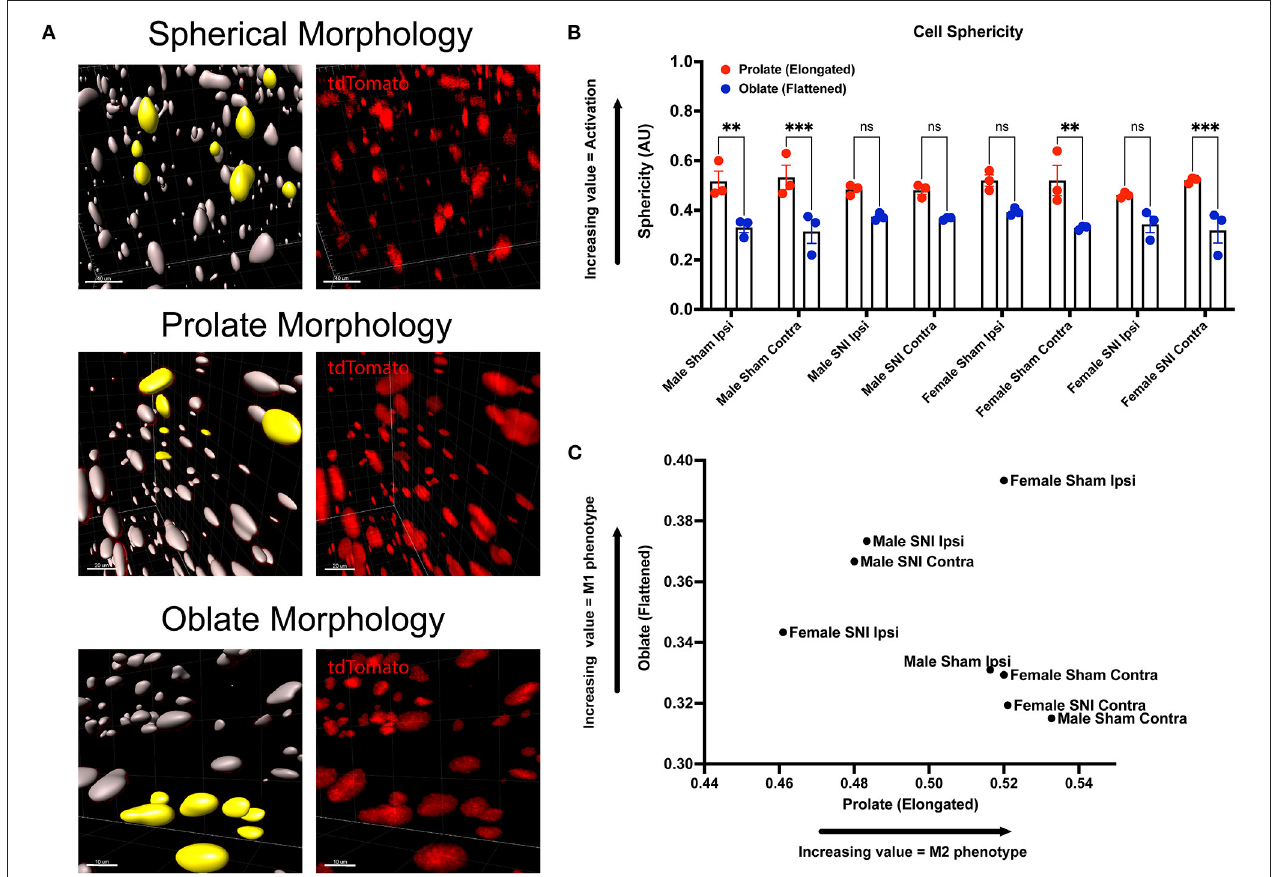
FIGURE 3 | Morphology of LysM tdT + macrophages in the lumbar DRGs 5 days post-SNI. Male and female LysM tdT + mice had DRGs harvested 5 days post-SNI. Tissues were processed and cleared using ScaleS1 solution for 10–14 days and imaged using 2-photon microscopy. (A) Representative morphology from male and female LysM tdT + (red; 1,100nm) DRGs ( n = 3). (B) Imaris analysis of LysM tdT + cell morphology in male and female DRGs. Cells were analyzed for three morphologic parameters (sphericity, prolate, and oblate) and are displayed comparing oblateness and prolateness with respect to sphericity. (C) Scatter plot of DRG LysM + cell oblateness with respect to prolateness in both male and female injury and control groups. ** p < 0.01; *** p < 0.001. Scale Bar: 100 µ m. IP, Ipsilateral; CO,